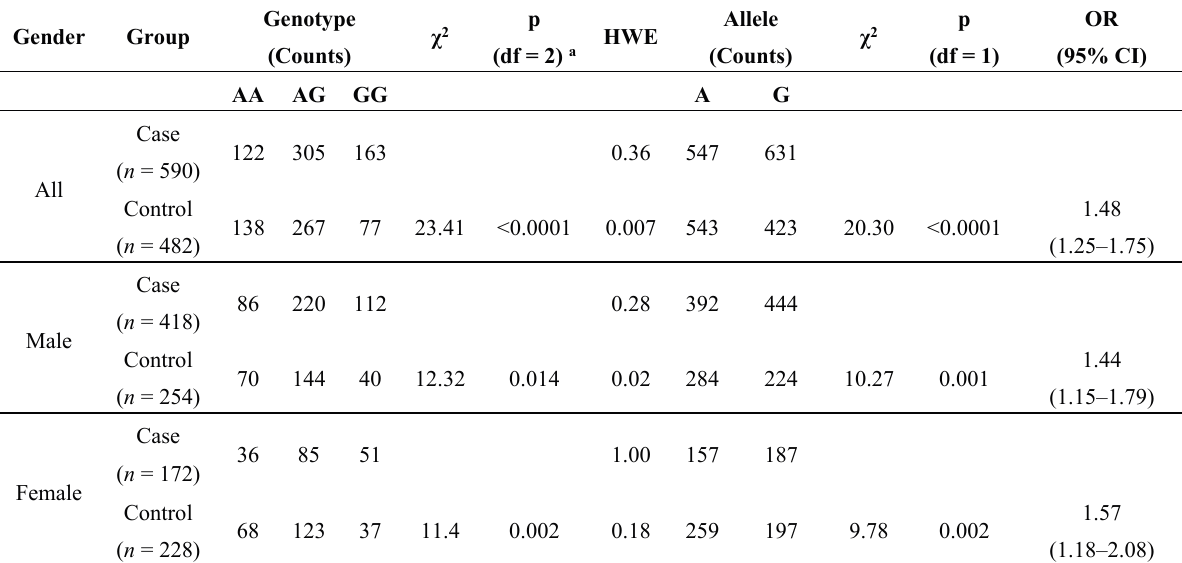
Table 2. Association test of rs4977574 between the CHD cases and non-CHD controls.